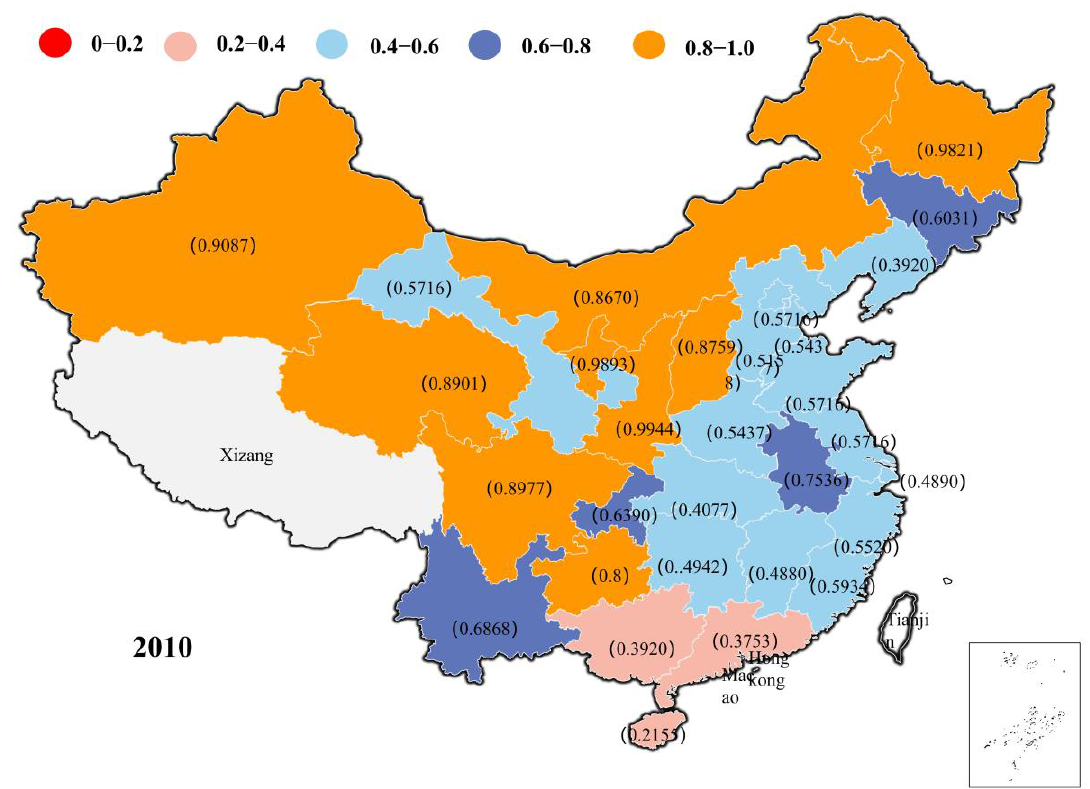
Figure 8. Spatial patterns of CERI scores in 2010 in 30 Chinese provinces.